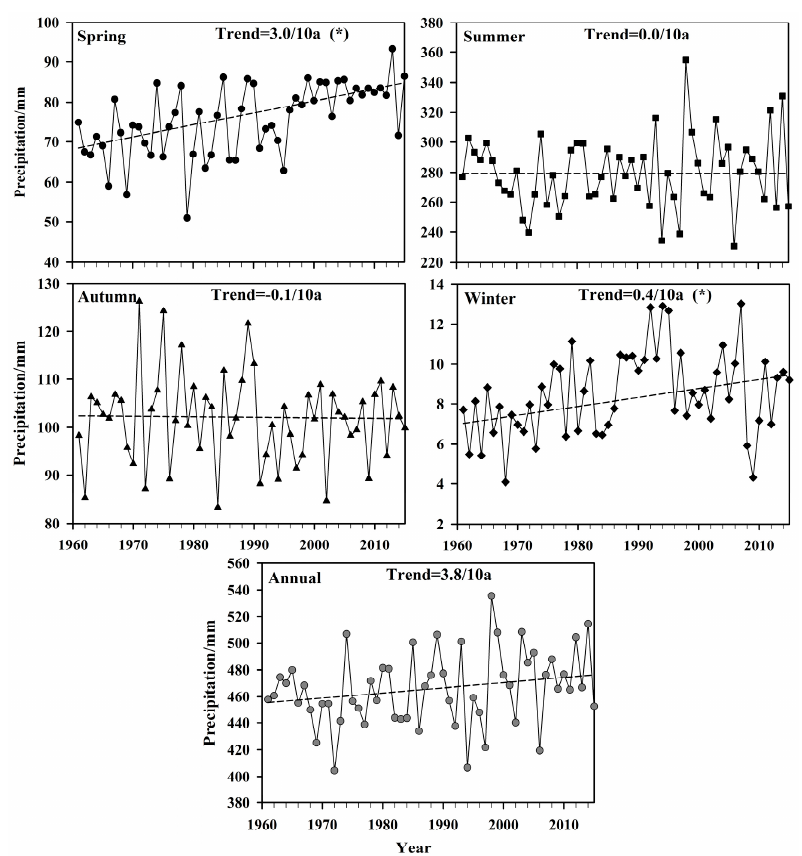
Figure 3. The trend in the annual and seasonal precipitation from 1961 to 2015 over the TP; * Represents significant at 95% level.